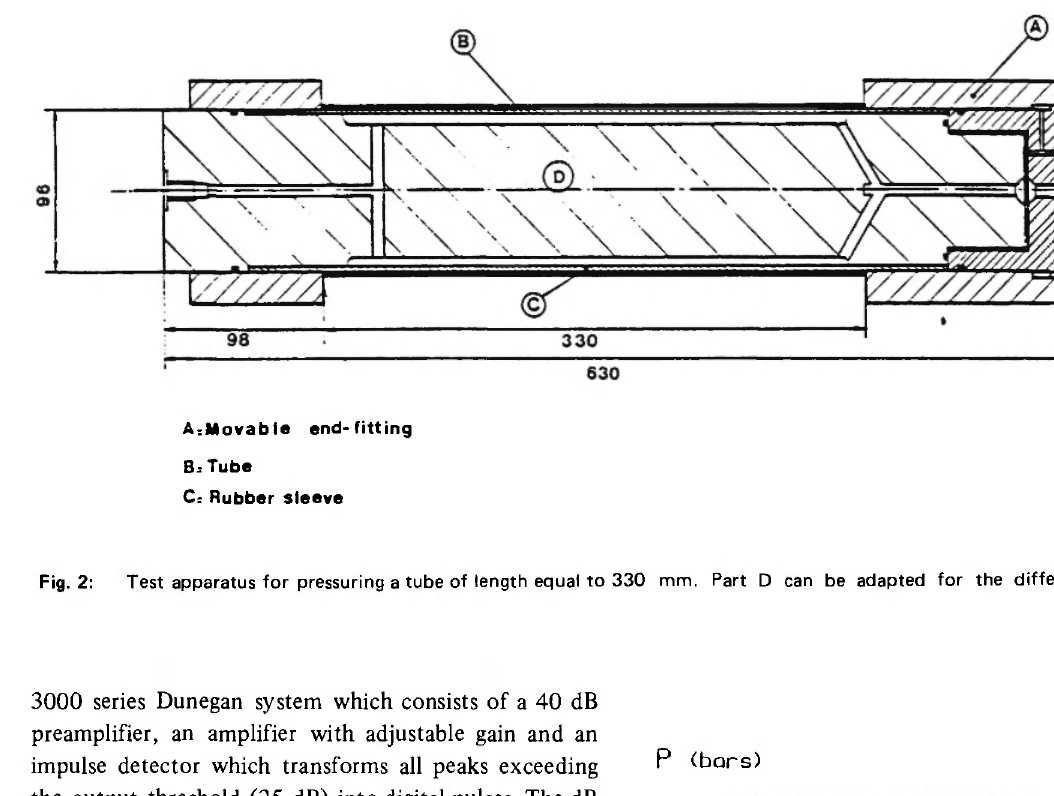
3000 series Dunegan system which consists of a 40 dB preamplifier, an amplifier with adjustable gain and an impulse detector which transforms all peaks exceeding the output threshold (25 dB) into digital pulses. The dB measurements were given in reference to a l^V signal at the transducer. The analysis system was set to have a dead time of 100 ßs which allowed one event only to be counted for each series of pulses separated by less than 100 /us.